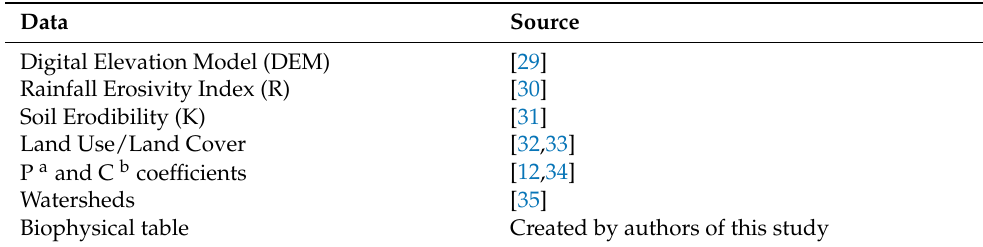
Table 1. Data sources for the data used as inputs for the Sediment Delivery Ratio (SDR) InVEST